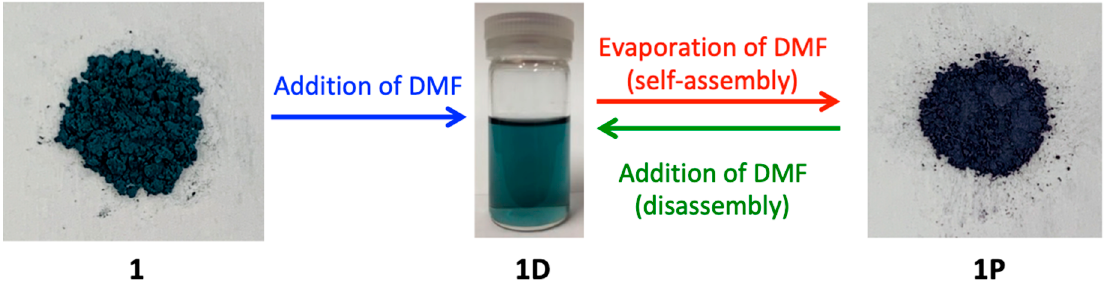
Figure 3. Pictures of 1 (green powder), 1D in DMF (green solution), and 1P in solid state (purple powder).